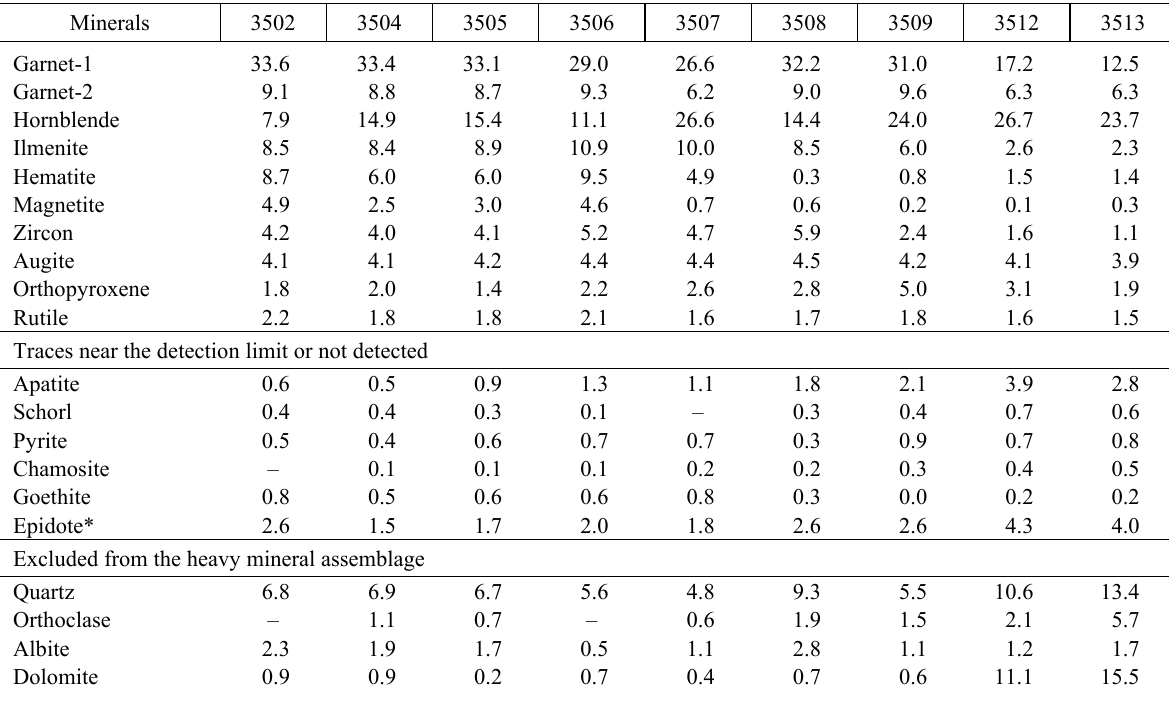
Table 3. Results of X-ray diffractometry of Lemme samples 3502–3509, 3512 and 3513 using the Rietveld method (wt%, 0.05– 0.1 mm fraction)